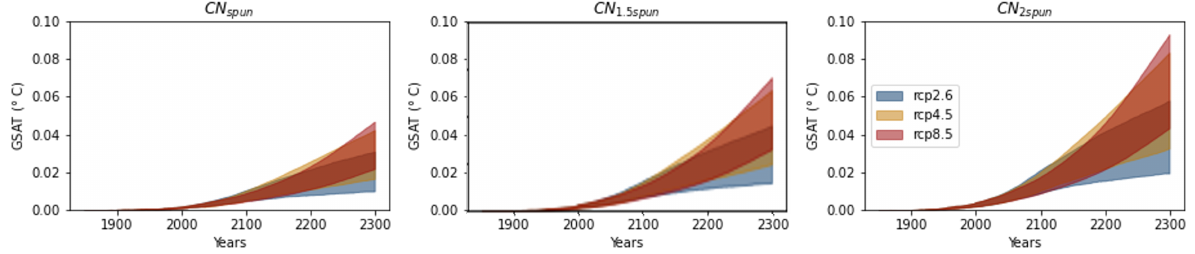
Figure A6. Loss of permafrost carbon as a percent of the initial labelled permafrost carbon and plotted as a function of initial permafrost carbon. The positive permafrost carbon feedback onto GSAT is shown in Figure A7 as a function of time. As expected, it is dependent on the initial carbon content and ranges between 0.001 and 0.03 °C by 2100 and 0.002 and 0.09 °C by 2300, with the higher the initial carbon content the higher the feedback.